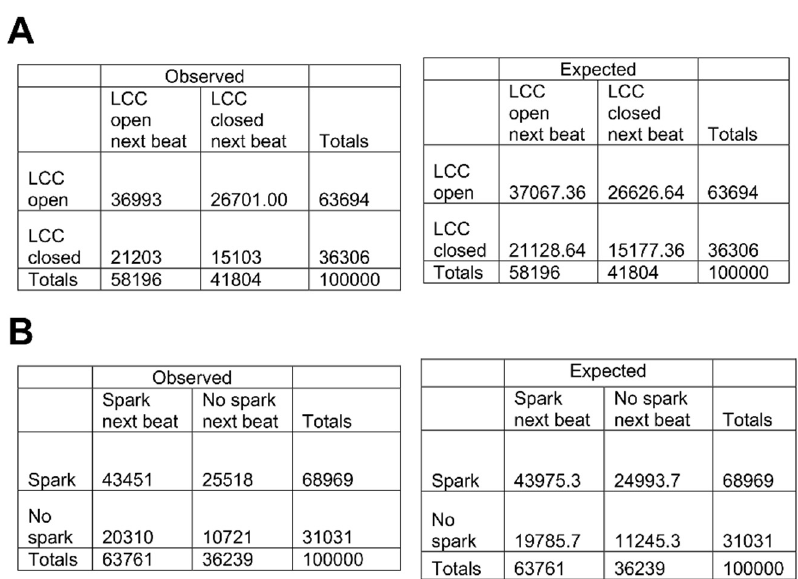
Figure 7. Contingency Tables for Spark Analysis. ( A ) Does L-type Ca 2+ channels (LCC) opening effect LCC opening in the subsequent beat? ( B ) Does a Ca 2+ spark in one beat affect Ca 2+ spark occurrence in the subsequent beat?